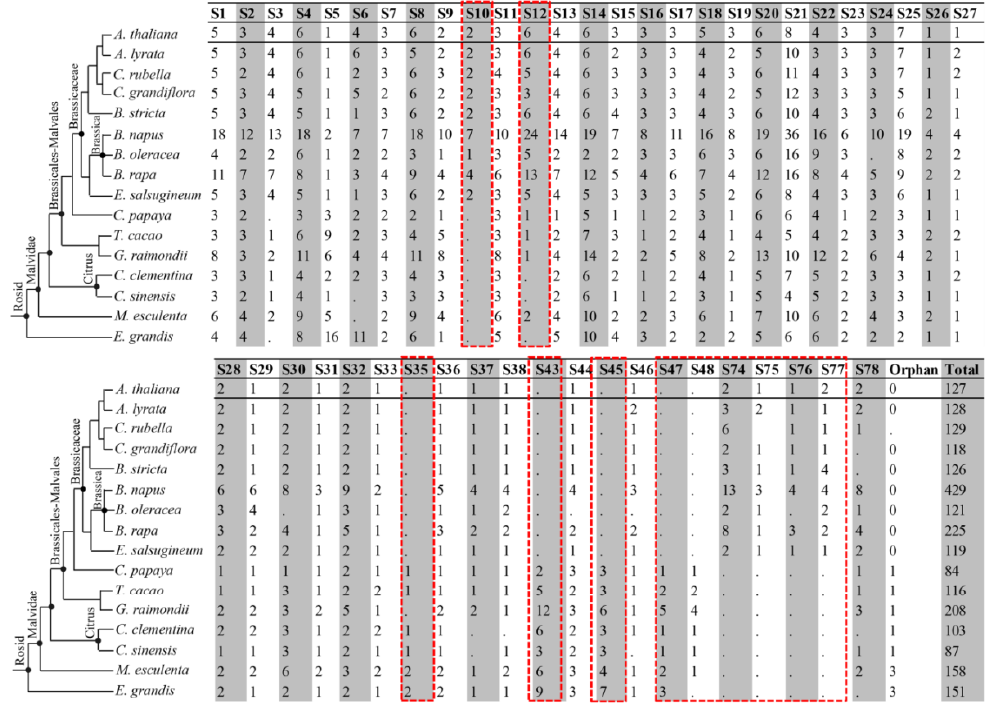
Figure 2. Presence/absence of the 2R-MYB genes in 16 representative plant genomes by phylogenetic Figure 2. Presence / absence of the 2R-MYB genes in 16 representative plant genomes by phylogenetic position. Numbers of 2R-MYB genes in each subfamily (S1 – S78) are shown. Red boxes indicate the position. Numbers of 2R-MYB genes in each subfamily (S1–S78) are shown. Red boxes indicate the lineage-specific subfamilies present or absent in nine Brassicaceae species. lineage-specific subfamilies present or absent in nine Brassicaceae